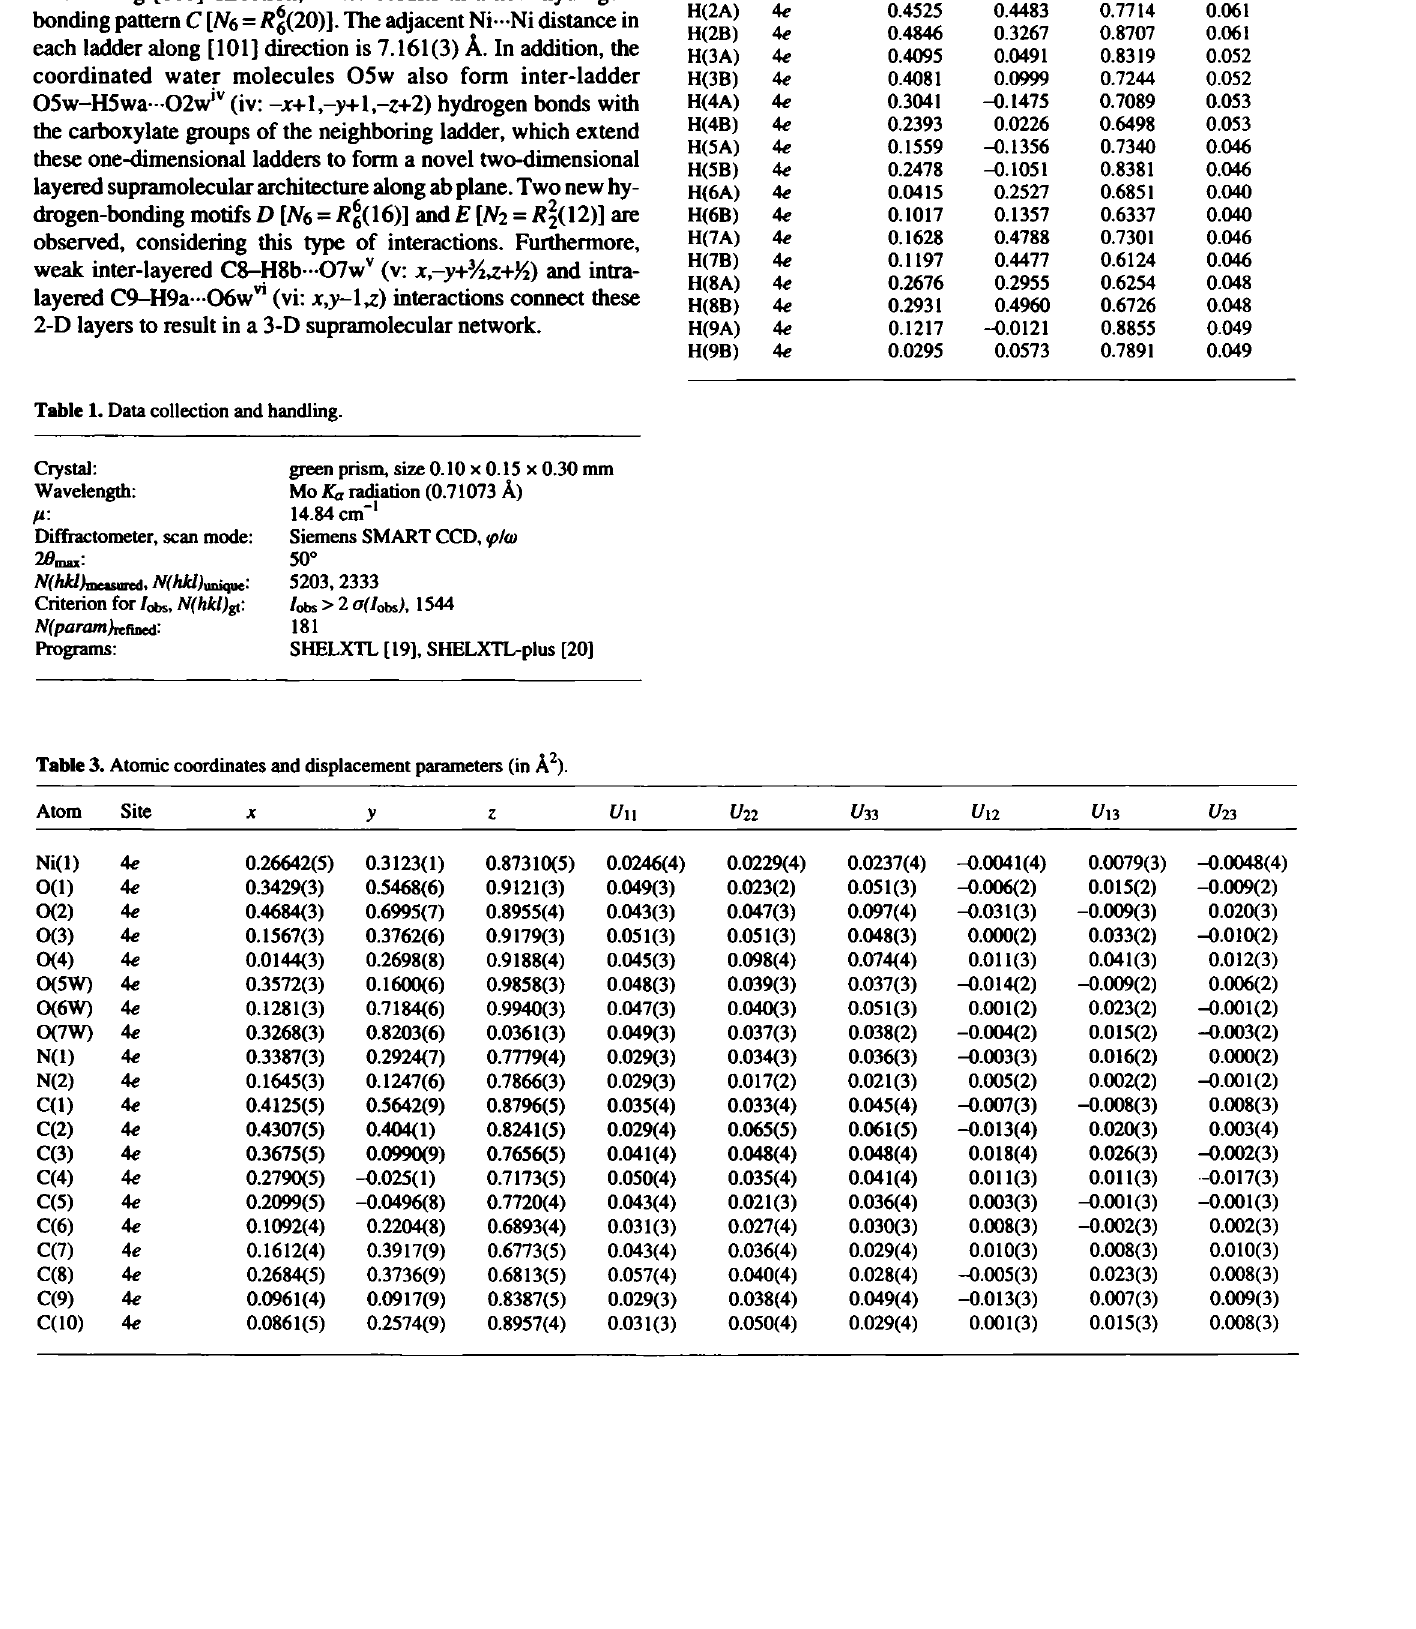
Table 1. Data collection and handling.